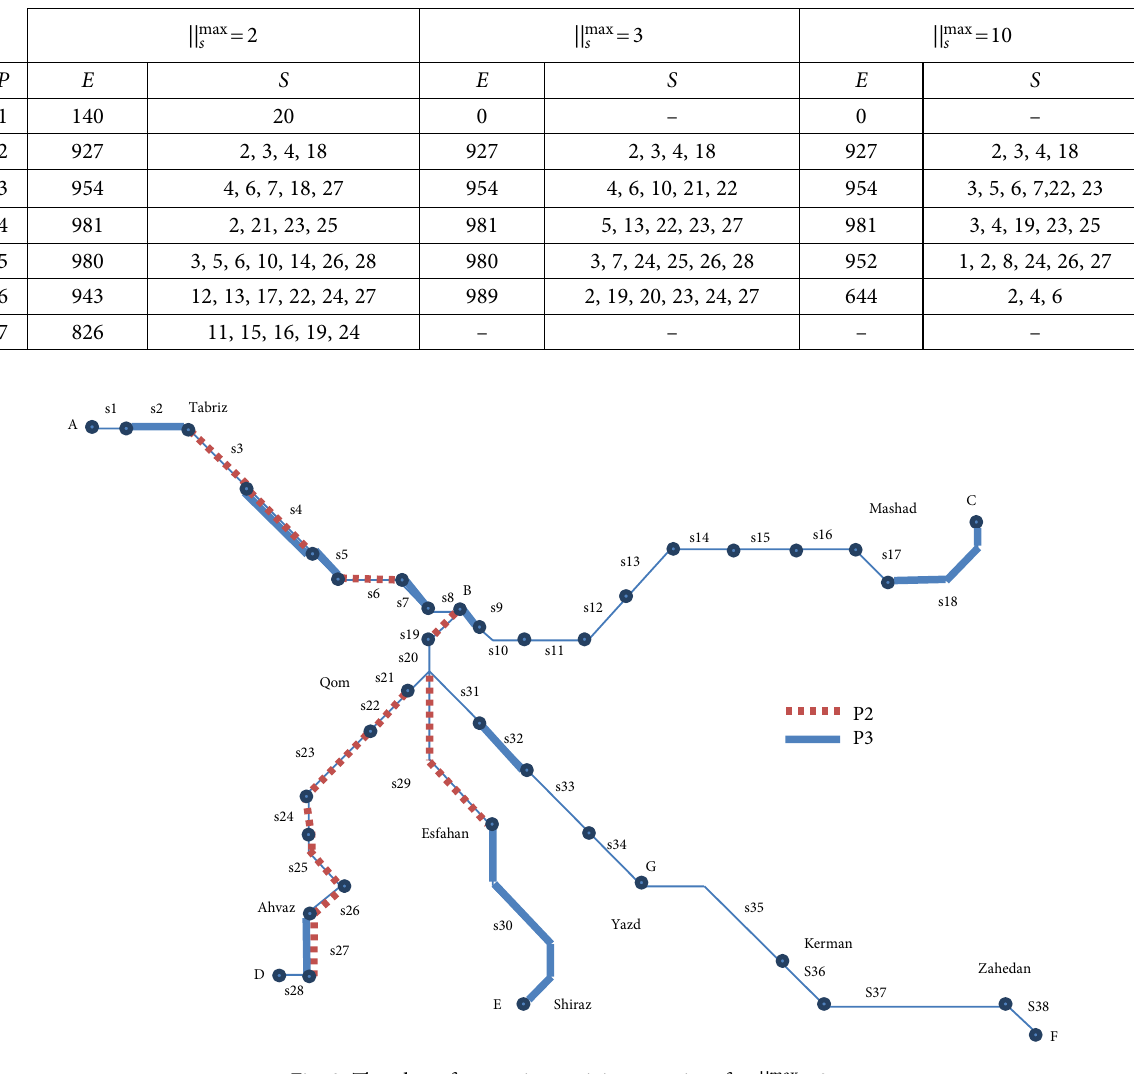
Fig. 8. The plan of expansion activity over time for